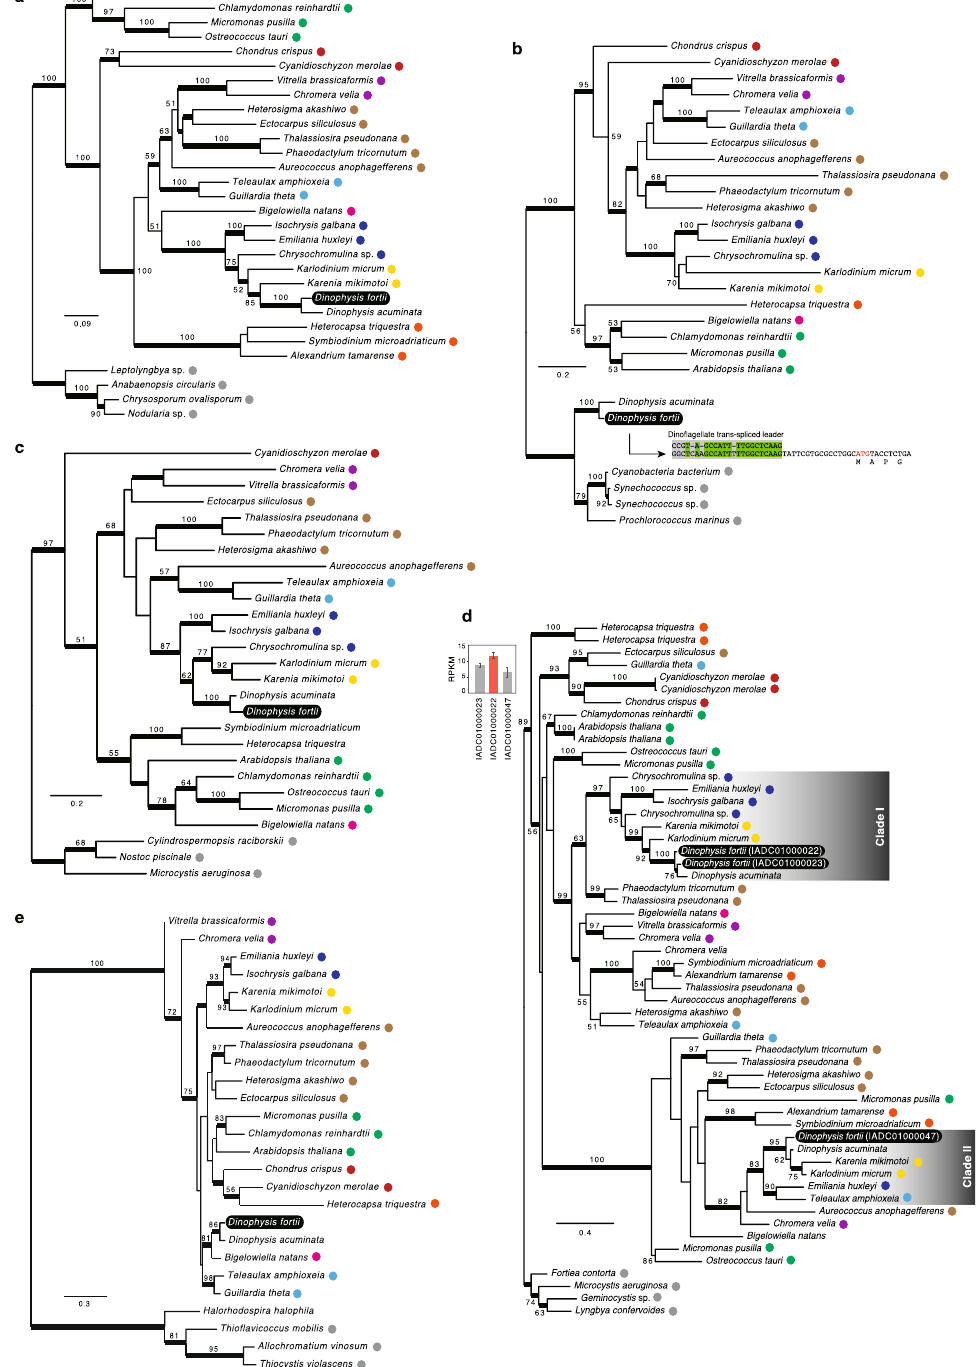
Figure 1. Maximum-likelihood trees of ( a ) ChlH, ( b ) ChlD, ( c ) ChlM, ( d ) POR and ( e ) ChlG. Bootstrap values ≥ 50% are shown. Nodes supported by Bayesian posterior probabilities ≥ 0.95 are highlighted with bold lines. Where two or more isoforms were identified, transcription levels are shown in the inset bar chart in the top left corner and the isoform with the highest transcription level is highlighted with a red bar in the bar chart. Transcriptome shotgun assembly (TSA) accession numbers are shown in parentheses. The alignment of the dinoflagellate splice leader sequence and 5 ′ -end of the chlD mRNA sequence is shown in ( b ). Coloured circles indicate proteins of peridinin dinoflagellates (orange), fucoxanthin dinoflagellates (yellow), Haptophyta (blue), Chlorarachniophyta (magenta), Cryptophyta (light blue), Chromerida (purple), Rhodophyta (red), Stramenopiles (brown), Viridiplantae (green) and Bacteria (grey). Proteins of Dinophysis fortii are presented on black background with white